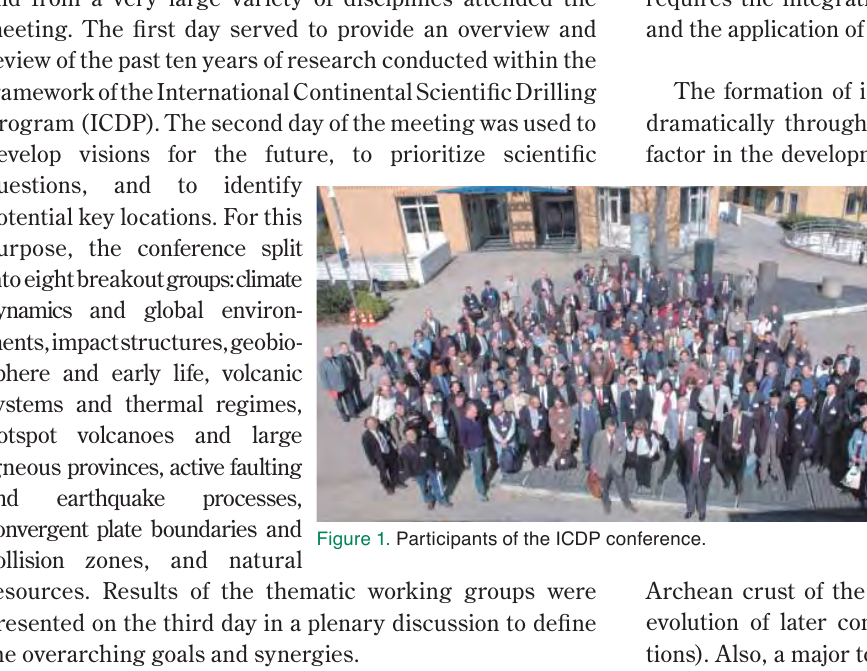
Figure 1. Participants of the ICDP